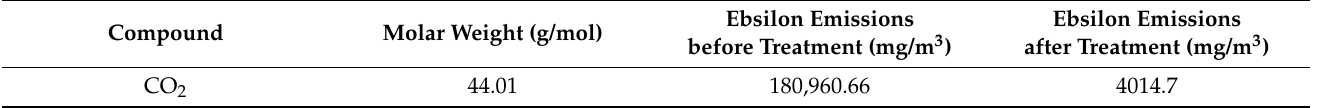
Table 13. CO 2 emissions before and after the reactor of CO 2